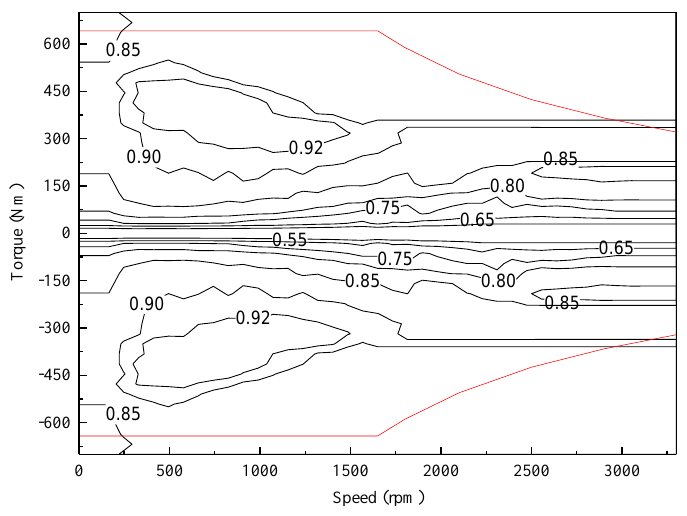
Figure 6. Efficiency contour diagram for a 111 kW M/G.